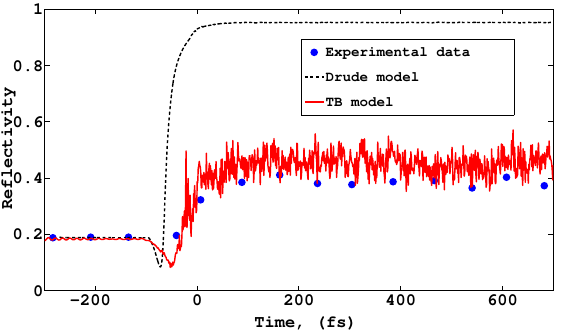
Figure 7. Optical reflectivity of diamond irradiated with the absorbed dose of 6.3 eV/atom. The dots are experimental data [30], the solid line depicts the results of the TB model with XTANT, the dashed line is Drude model. The simulations were performed with 216 atoms in the supercell. The figure is reproduced from